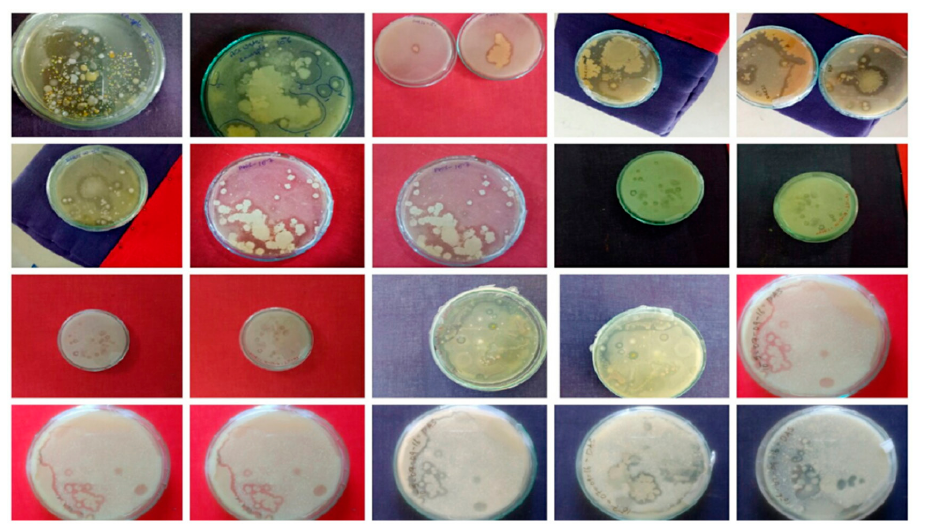
Fig. 3. Selection of protease positive colonies after 48 hrs. of